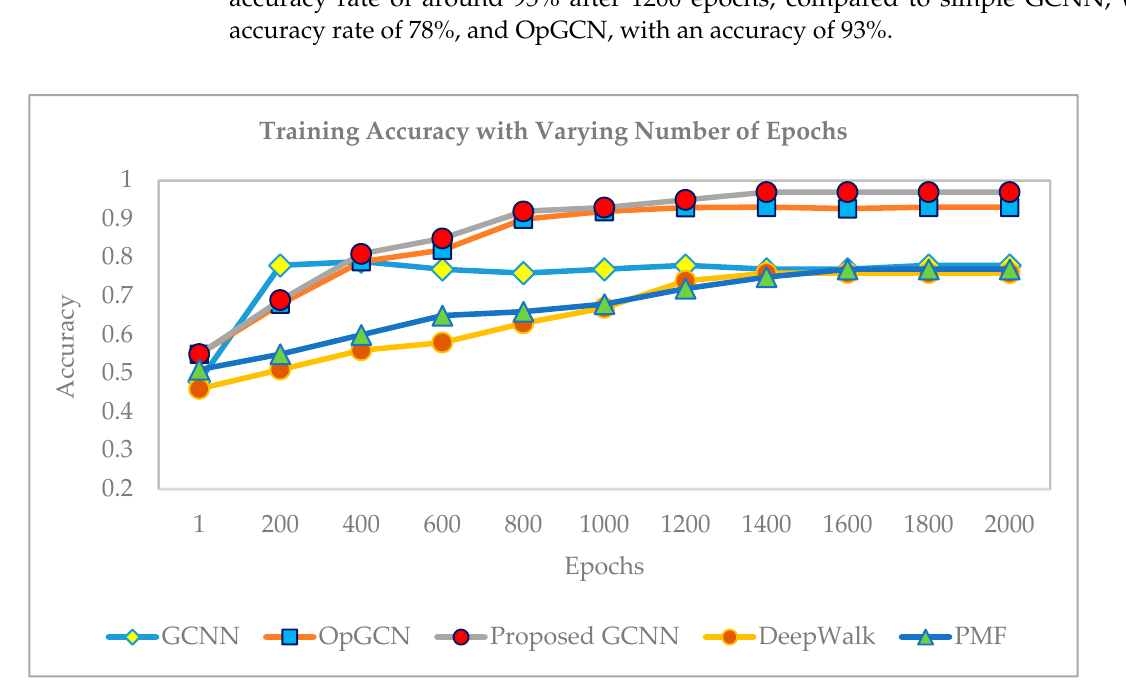
Figure 7. Training accuracy against the number of epochs.